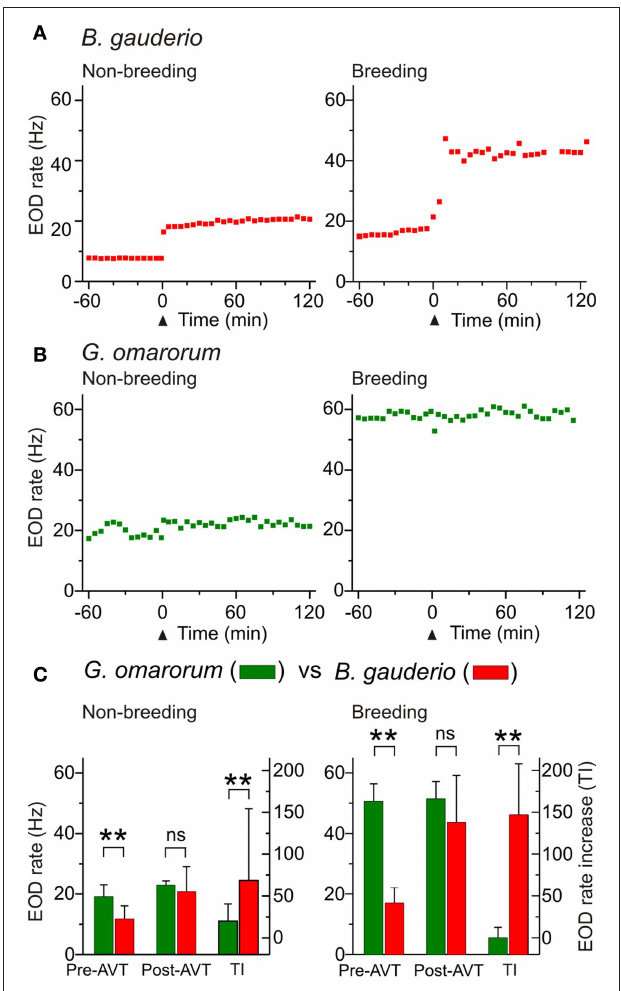
FIguRE 2 | Effects of AVT upon EOD rate in Brachyhypopomus gauderio and Gymnotus omarorum across seasons. (A,B) EOD rate as function of time during daytime in isolated fish during the non-breeding (water temperature: 20–22 ° C) and breeding (water temperature: 27–29 ° C) seasons. AVT was administered at time = 0 (arrowhead). (A) B. gauderio : a long-lasting step-like increase of EOD rate was observed in representative individuals immediately after AVT injection (IP, 10 μg/gbw) in both the non-breeding and breeding seasons. (B) G. omarorum : no effect of AVT (IP, 10 μg/gbw) on EOD rate was observed in representative individuals in either the non-breeding or breeding seasons. (C) Left axes: EOD rate of B. gauderio and G. omarorum 1 h before AVT administration (10 μg/gbw) and 60–120 min after. Right axes: Amplitude of the increase of EOD rate induced by AVT (10 μg/gbw) in both species. Bars represent medians (IQR) of the representative EOD rate values and of treatment indexes (TI, see Materials and Methods). ** p < 0.01, Mann Whitney U test. ns: